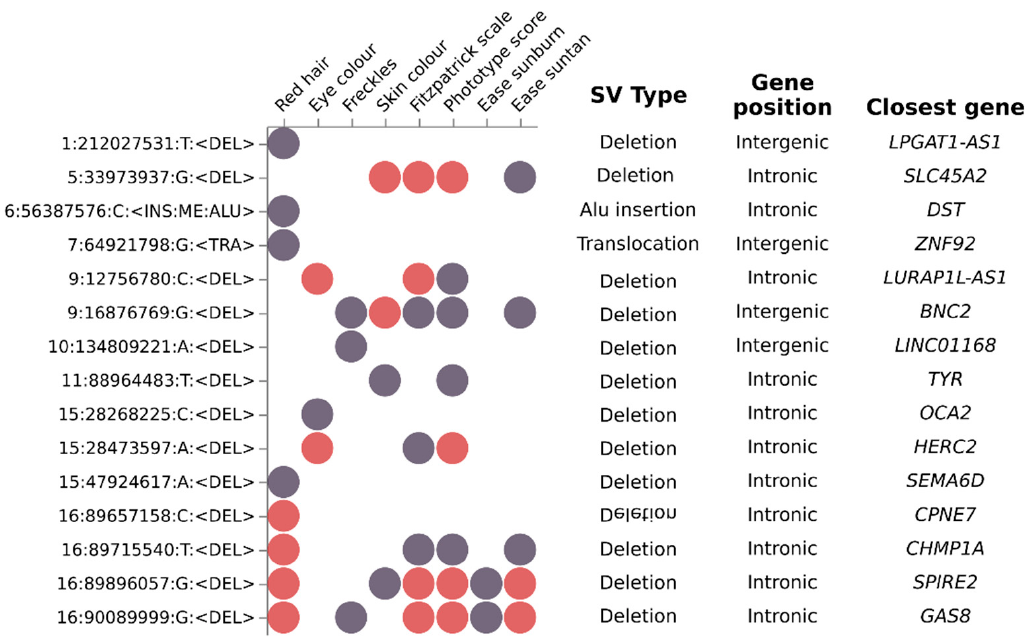
Figure 4. Genome-wide analysis identified structural variants significantly associated with a subset of pigmentary traits. Dot-plot depicting the suggestive (purple dots) and significant (red dots) association of fifteen SVs (Y axis) with a subset of eight pigmentary traits (X axis). Additional SV information are shown in SV type (deletion, Alu insertion and translocation), Gene position and Closest gene columns. Most Identified SV were deletions located in intronic regions.